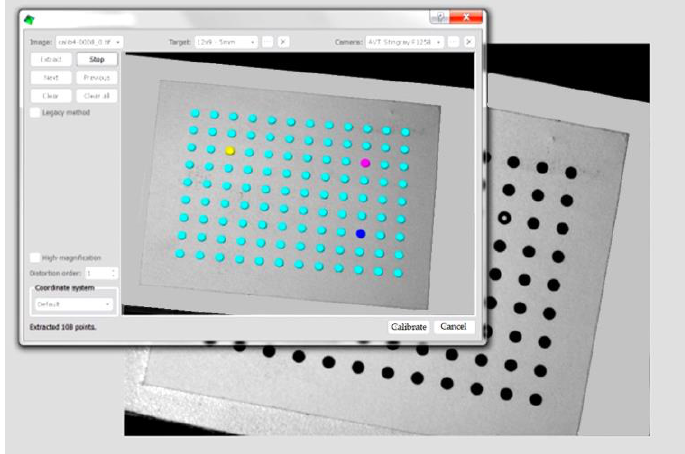
Figure 5. The extracting of the calibration points during the stereo calibration assured by means of the VIC-3D software.